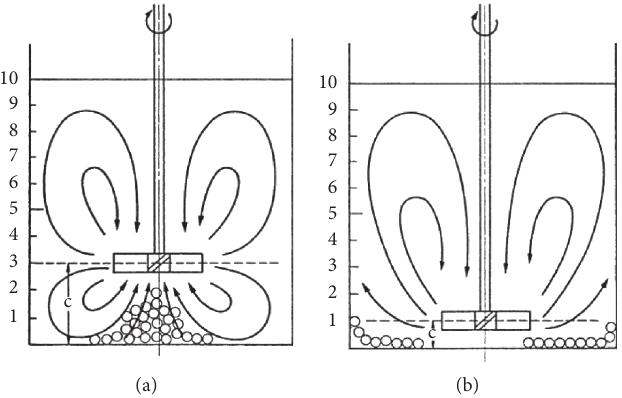
Figure 1: (a, b) Two types of solid particle fluidization [46].